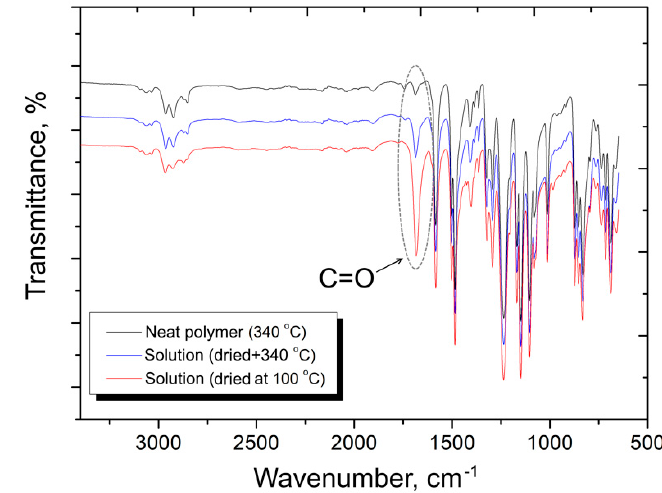
Figure 3. Infrared spectra of polysulfone after various treatments